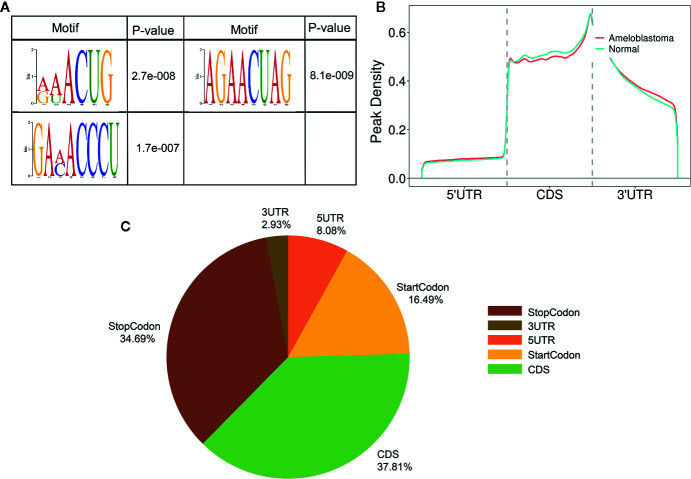
Characteristics of m6A peaks within mRNAs, lncRNAs and circRNAs in ameloblastoma and adjacent normal oral tissues. (A) Top motifs enriched from all identified m6A peaks within mRNAs, lncRNAs and circRNAs in ameloblastoma tissues compared to adjacent normal oral tissues. (B) Difference in the density of m6A peaks in the indicated regions between ameloblastoma and adjacent normal oral tissues. (C) Pie diagram showing the distributions of m6A peaks in the whole transcriptome of ameloblastoma tissues and adjacent normal oral tissues.